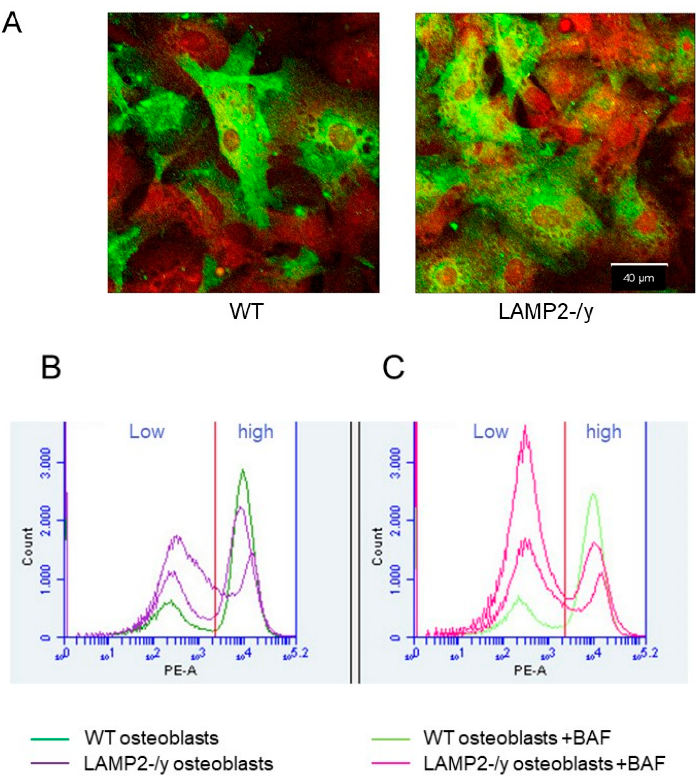
Figure 6. Immunolocalization and Fluorescence-activated cell sorting (FACS) analysis of RANKL in wild-type and LAMP-2 - / y osteoblasts. ( A ) WT and LAMP-2- / y osteoblasts were labeled for RANKL and visualized with alexa-488 (green), the nuclei were stained with propidium iodide (red). About 50% of the osteoblasts from both, WT and LAMP-2 - / y mice are intensely labeled for RANKL. ( B ) FACS analysis showed that membrane-bound RANKL (labeled with Phycoerythrin (PE)) was not highly expressed by all osteoblasts. Part of the osteoblasts show low membrane labelling (left side of the graph (Low)). WT osteoblasts (purple line) have more RANKL on their plasma membrane than LAMP-2- / y osteoblasts (dark blue line in graph B right side (high)). ( C ) When osteoblasts were incubated with bafilomycin, a lower number of cells were found in the high membrane labeling fraction. This is seen at the right side of the figure (high). This counts for WT as well as LAMP-2- / y cells. WT with bafilomycin (pink line), LAMP-2- / y with bafilomycin (light green line).